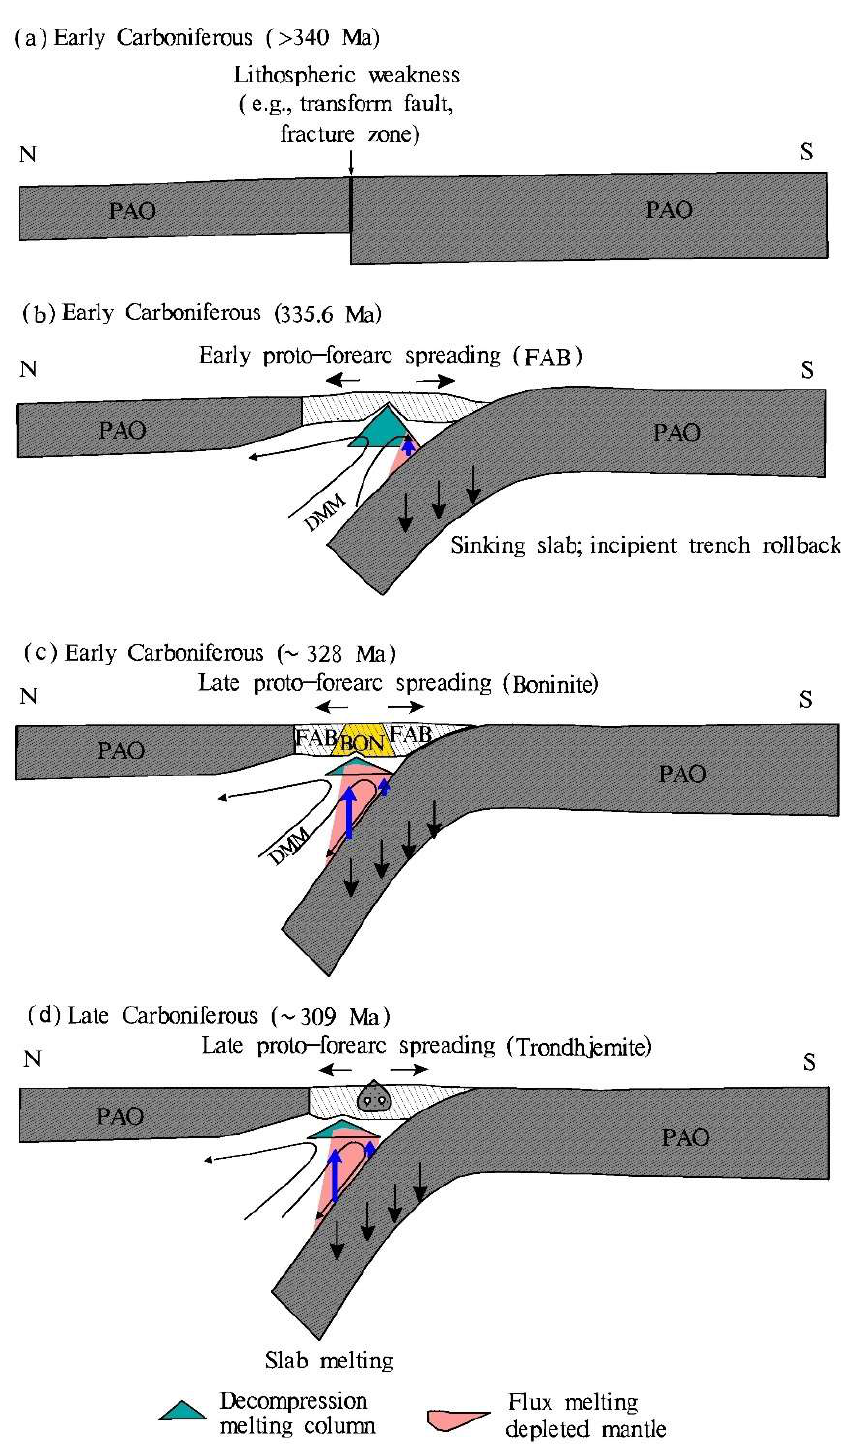
Figure 9. Evolution of the early Carboniferous to late Carboniferous Diyanmiao intra-oceanic forearc system in central Inner Mongolia as based on the subduction infancy model [21,32,66–68]. ( a ) Oceanic crust boundary preceding subduction initiation. ( b ) Early Carboniferous subduction initiation, leading to forearc spreading and formation of FABs. ( c ) As the s6ubduction initiation process continued, boninites were formed. ( d ) As the subduction process continued, the oceanic crust partially melts at a deeper depth, trondhjemite were form. DMM is depleted MORB mantle. FAB—forearc basalt. PAO—Paleo-Asian